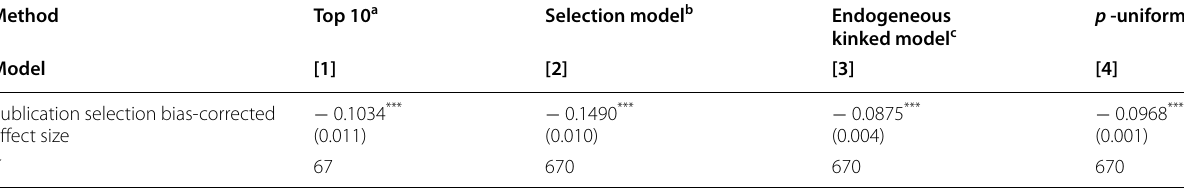
Table 7 Alternative estimates of publication selection bias–corrected effect